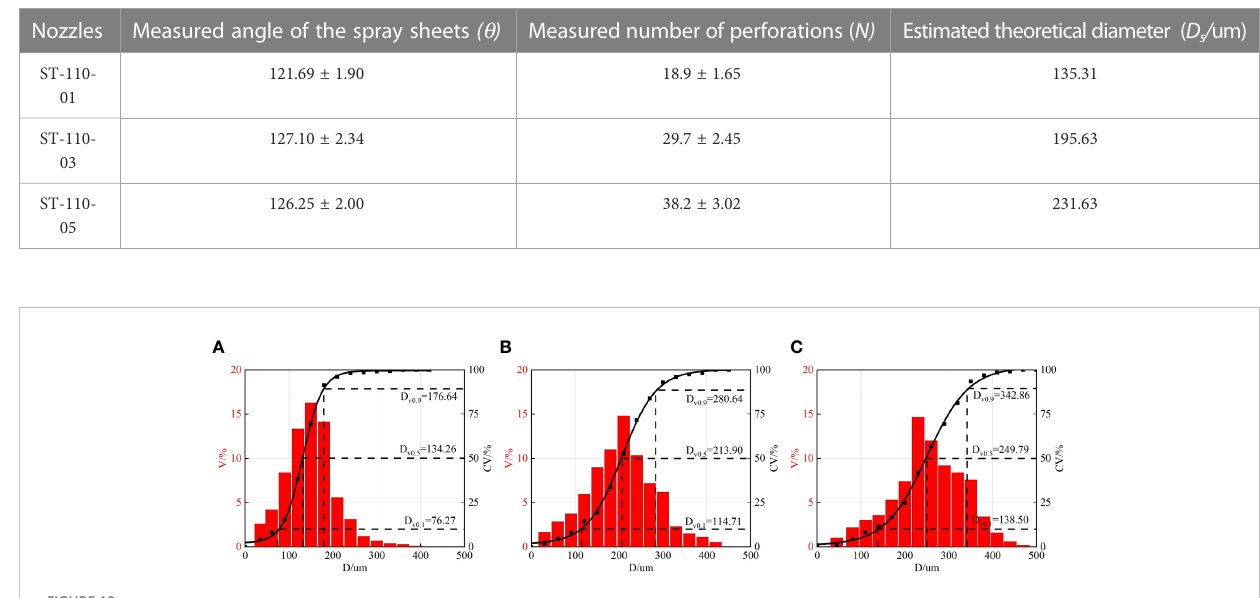
TABLE 3 Theoretical results at different nozzle con fi gurations.